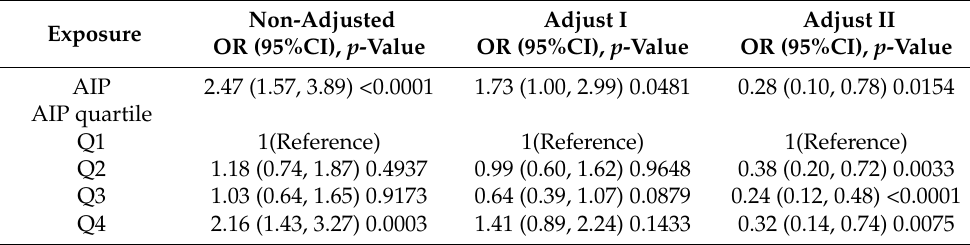
Table 2. Associations between the atherogenic index of plasma and the risk of heart failure.